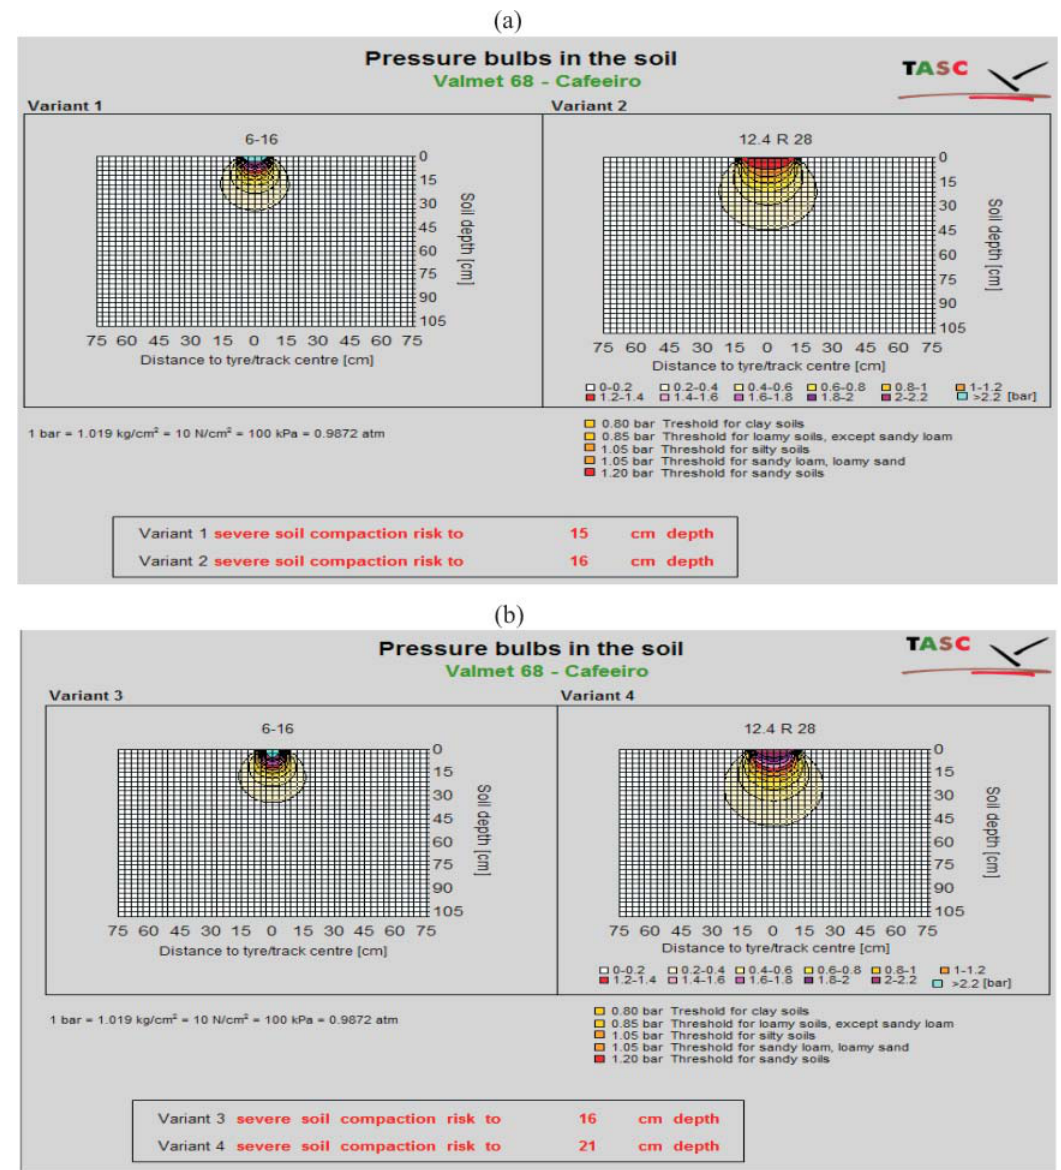
Figura 1. Bulbos de tensão obtidos para os pneus dianteiros 6-16 (variantes 1 e 3) e traseiros 12.4-R28 (variantes 2 e 4) do trator Valmet ® 68 cafeeiro, considerando o solo sem preparo (a) e o solo com preparo regular